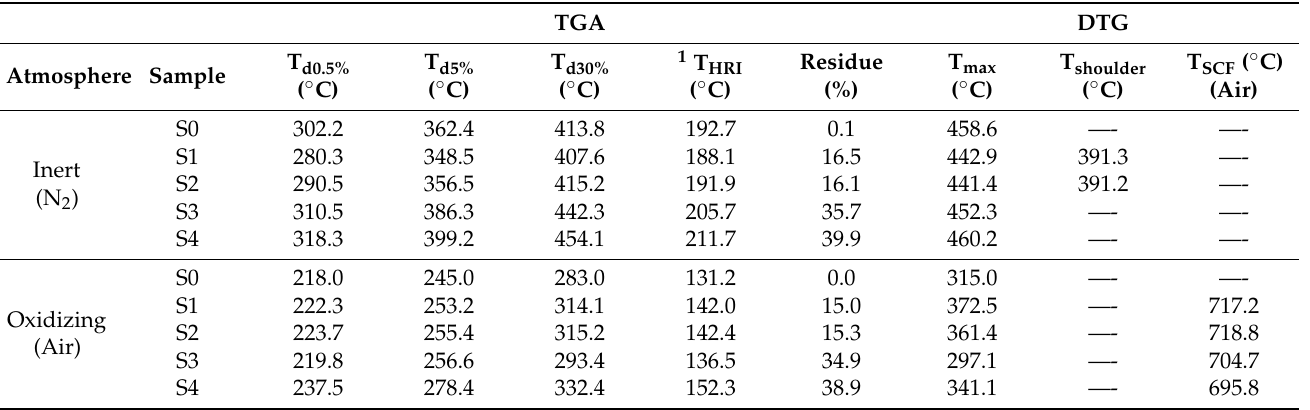
Table 2. Thermal parameters obtained from TGA analysis in Figure 2A,B.